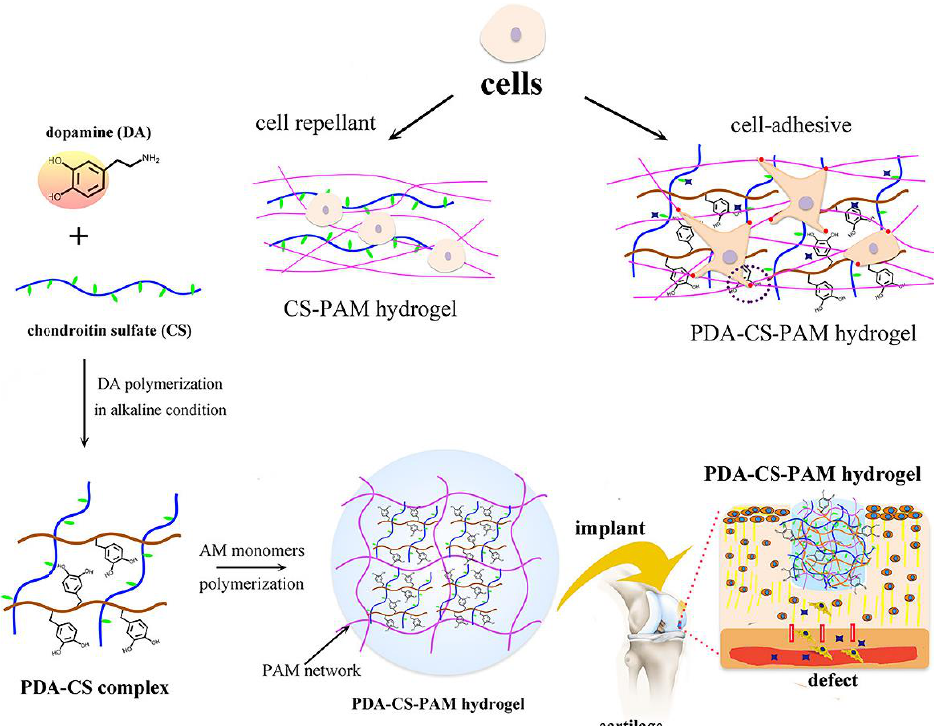
Figure 8. Chondroitin sulfate-based hydrogel bio-adhesive: preparation process and application of mussel-inspired chondroitin sulfate-based hydrogel bio-adhesives. Reprinted with permission from ref [148]. Copyright 2022 American Chemical Society.